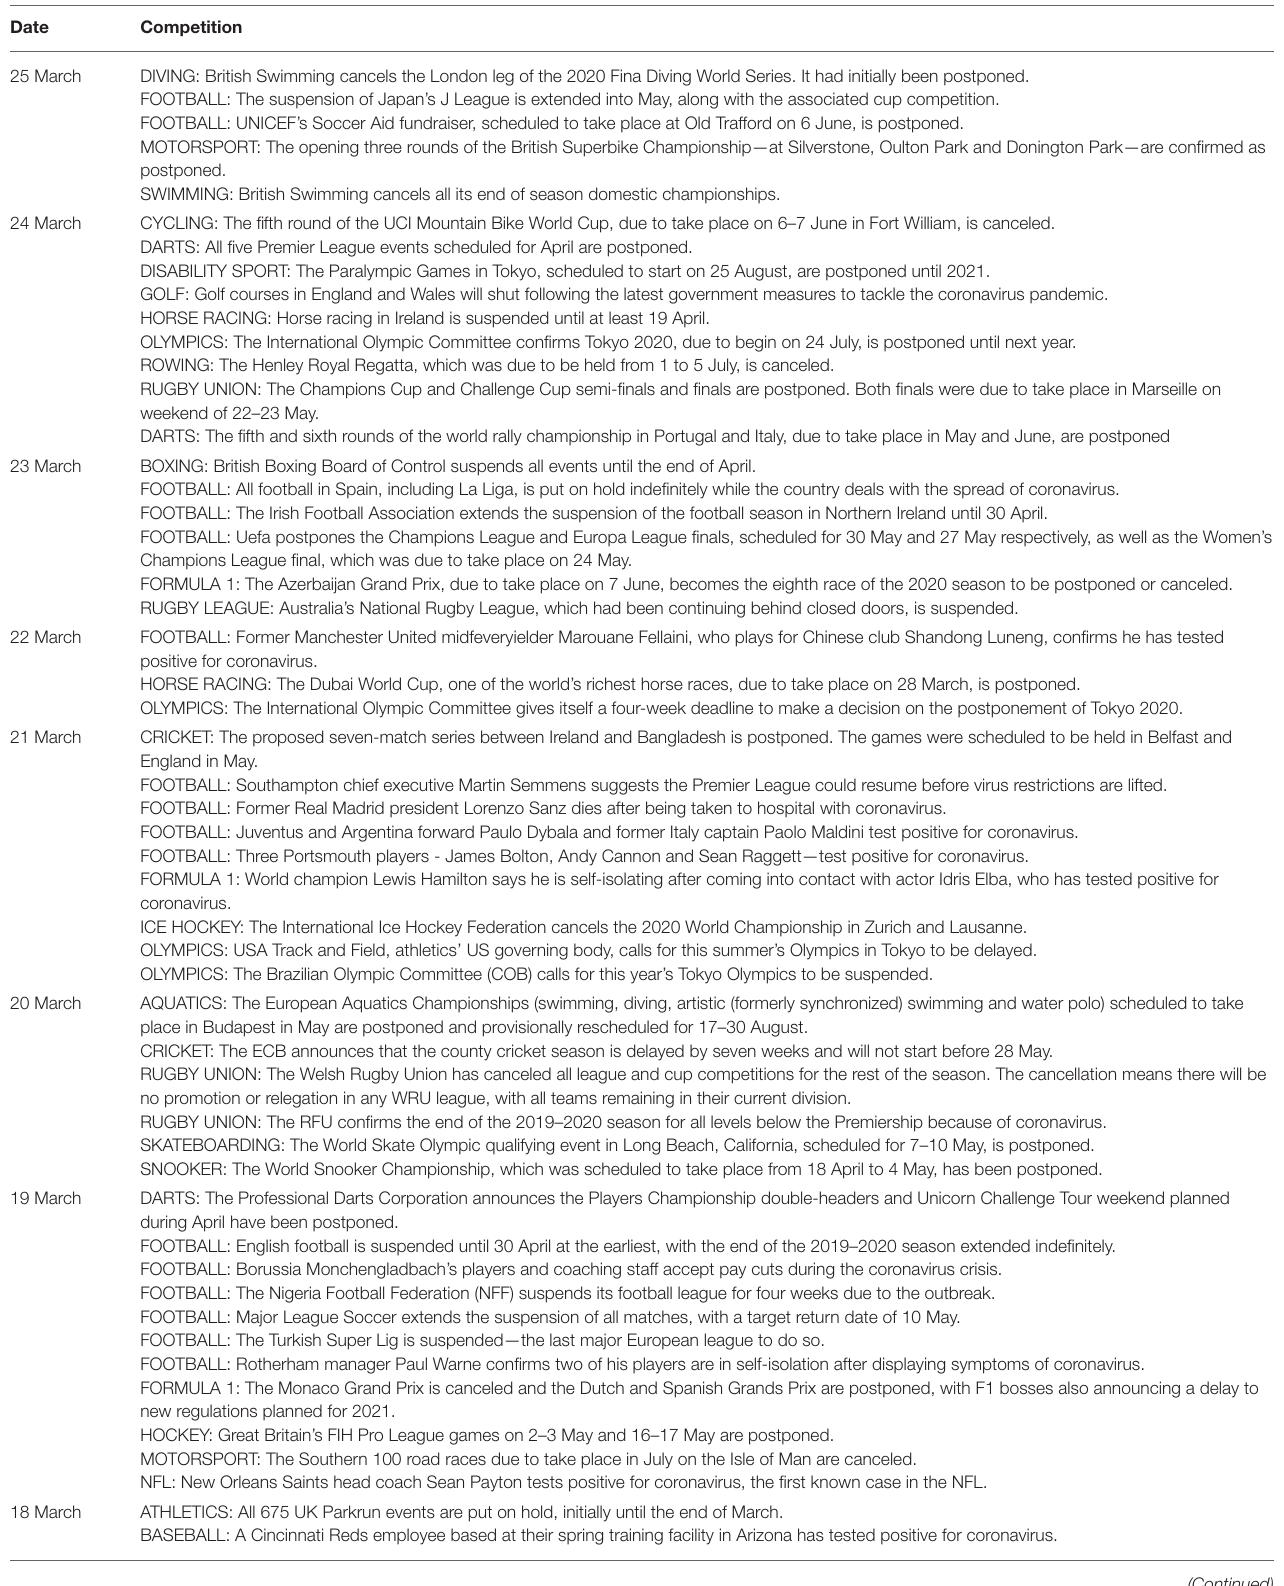
TABLE 1 | Examples of sporting events, the schedule of which has changed over the past 10 days due to coronavirus